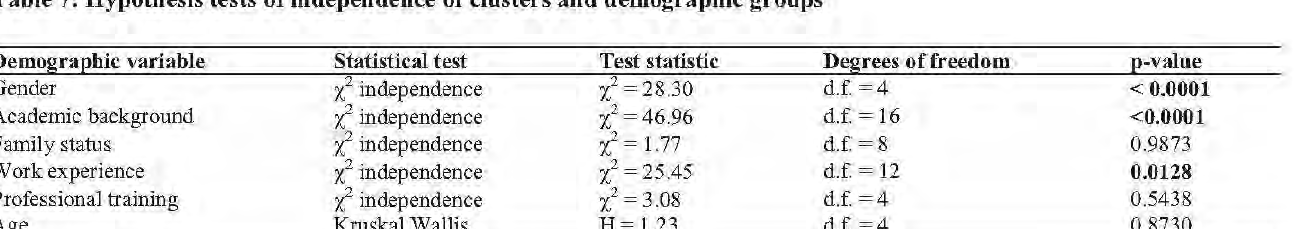
Table 7: Hypothesis tests of independence of clusters and demographic groups Demographic